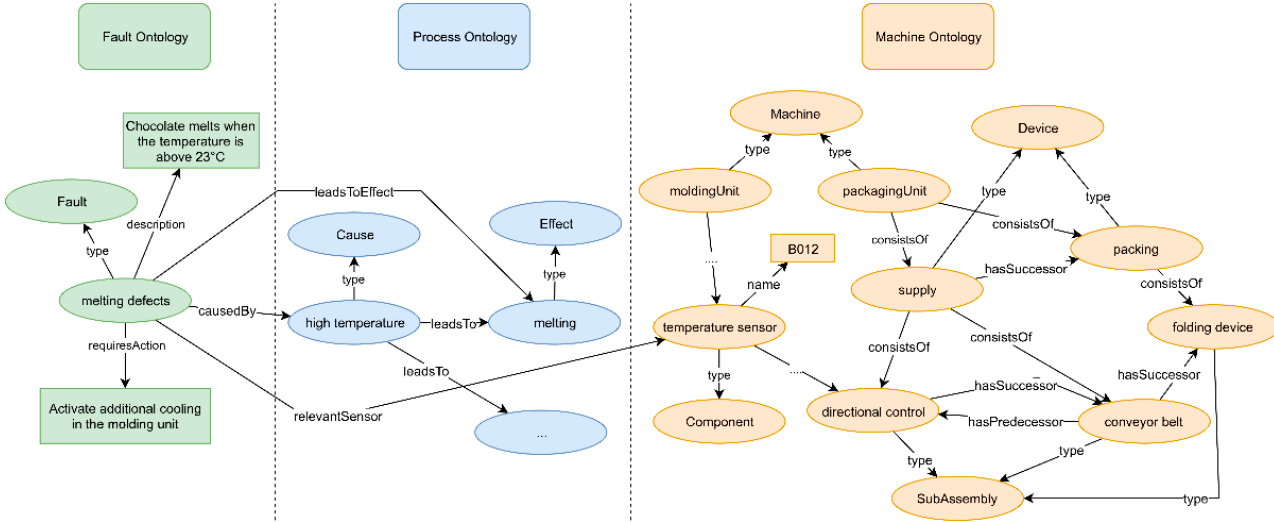
Figure 2. Schematic representation of connected ontologies for faults, process, and machines. Oval shapes represent resources (i.e., concepts), rectangles represent literals (i.e., text strings).